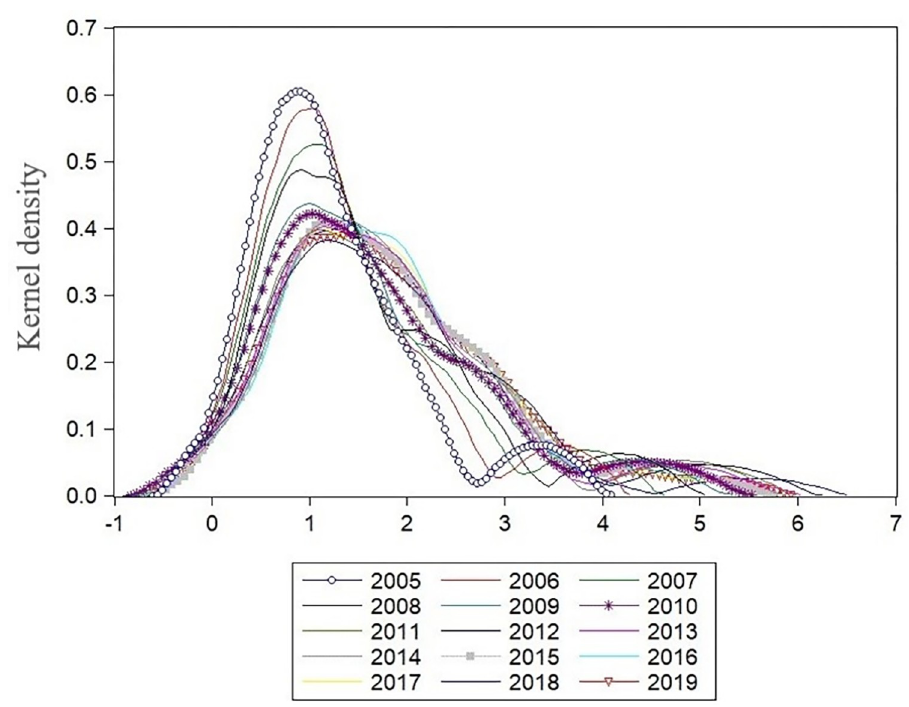
Fig 4. National provincial Kernel density function curve distribution estimation